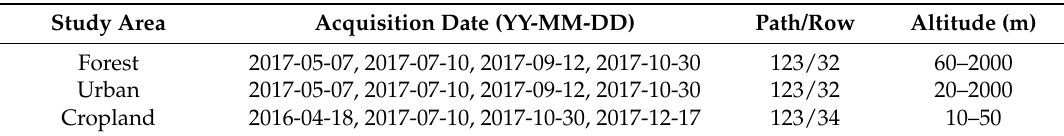
Table 1. Description of the Landsat 8